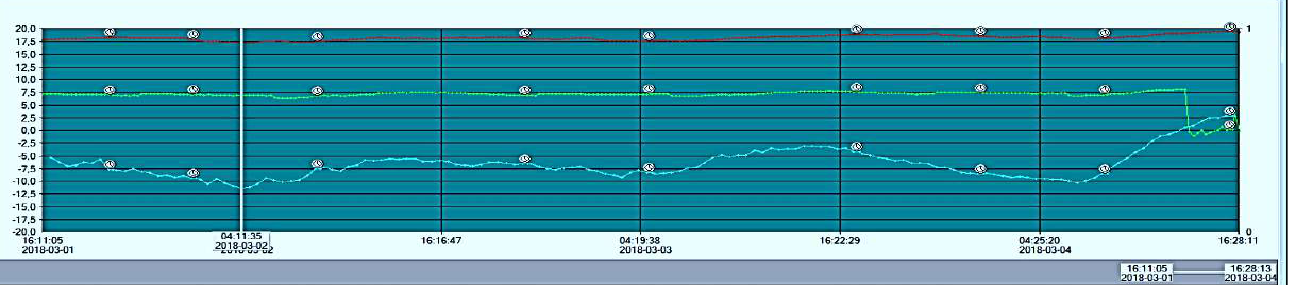
Figure 4. Results of air handling unit operation over 3 days of 2018, FCH HVAC BMS, presenting the scale of recovery (shown in green) of groundwater energy in a period of low temperatures. Color blue—outdoore temperature, color green—temperature from the heaters, color red—indoore temperature.